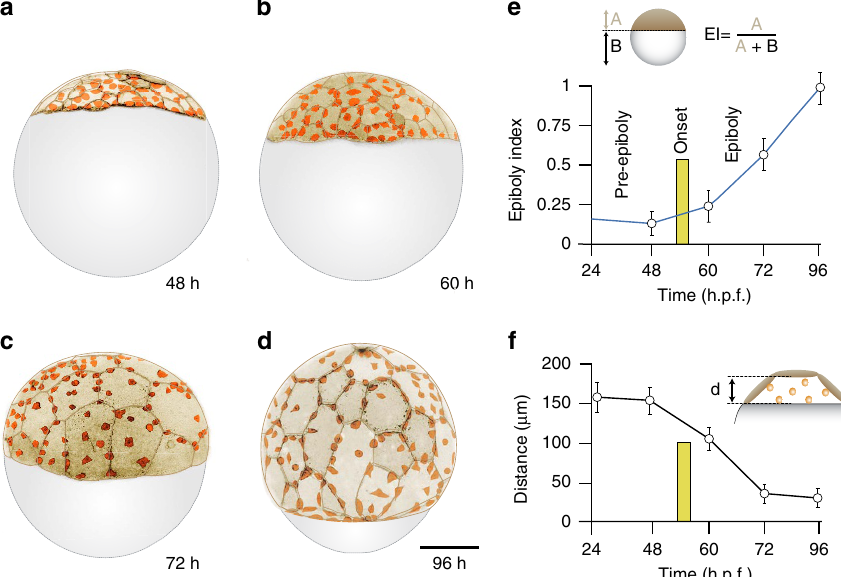
Figure 1 | Stages of epiboly in the annual killifish Austrolebias nigripinnis . ( a – d ) Lateral views of embryos expressing lifeact-GFP at late blastula ( a ) and during different stages of epiboly: 30–35% ( b ), 60–65% ( c ) and 85–90% ( d ). Images correspond to confocal microcopy z-stack maximum projections, with an inverted look-up table, and pseudocoloured in light brown for the EVL and orange for cells of the DCL. ( e ) Temporal changes in the epiboly index, defined by the position of the blastoderm margin along the animal–vegetal axis of the embryo (see formula at the top). ( f ) Temporal changes in the height of the blastocyst cavity, defined by the distance between the EVL basal surface and the inner surface of the YSL along the animal–vegetal axis. Numbers in ( a – d ) indicate hours post-fertilization. The vertical yellow line in e and f indicates the onset of epiboly, defined by the initial vegetal-ward movement of the EVL epithelial margin. Scale bar, 250 m